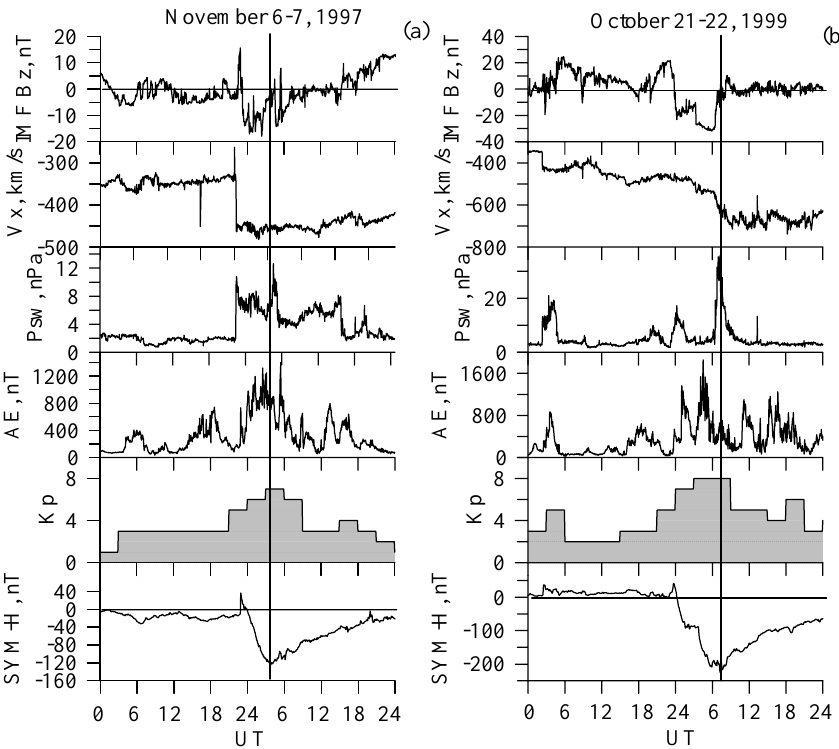
Fig. 1. Overview of the magnetic storms on (a) 6–7 November 1997 and (b) 21–23 October 1999. The solar wind and IMF data were obtained from Wind spacecraft taking into account the time shift of about 40min. AE, Kp and SymH indices data were obtained from World Data Center C2 for Geomagnetism, Kyoto. Thick black vertical lines mark the time moment of minimum in SYM-H index through all panels at both